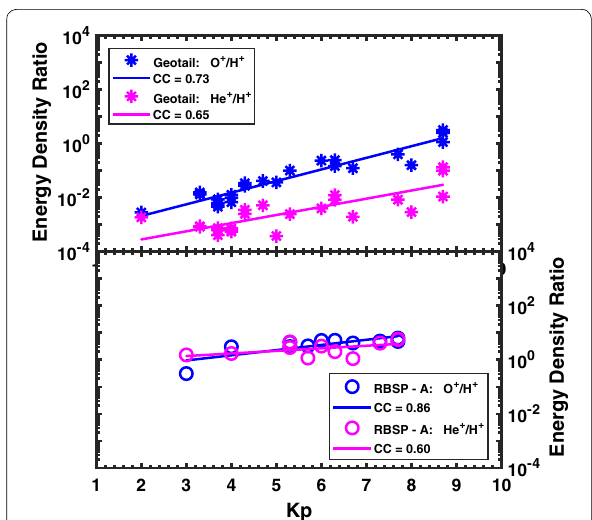
Fig. 10 Based on Geotail and RBSP-A observations, variation of energy density ratio for O + /H + and He + /H + with respect to Kp is shown. Blue and pink data points correspond to the energy density ratios of O + /H + and He + /H + , respectively. Black-colored regression line corresponds to each data